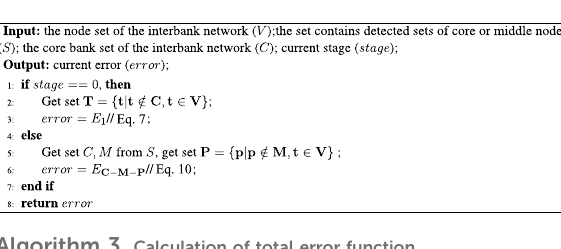
Algorithm 3. Calculation of total error